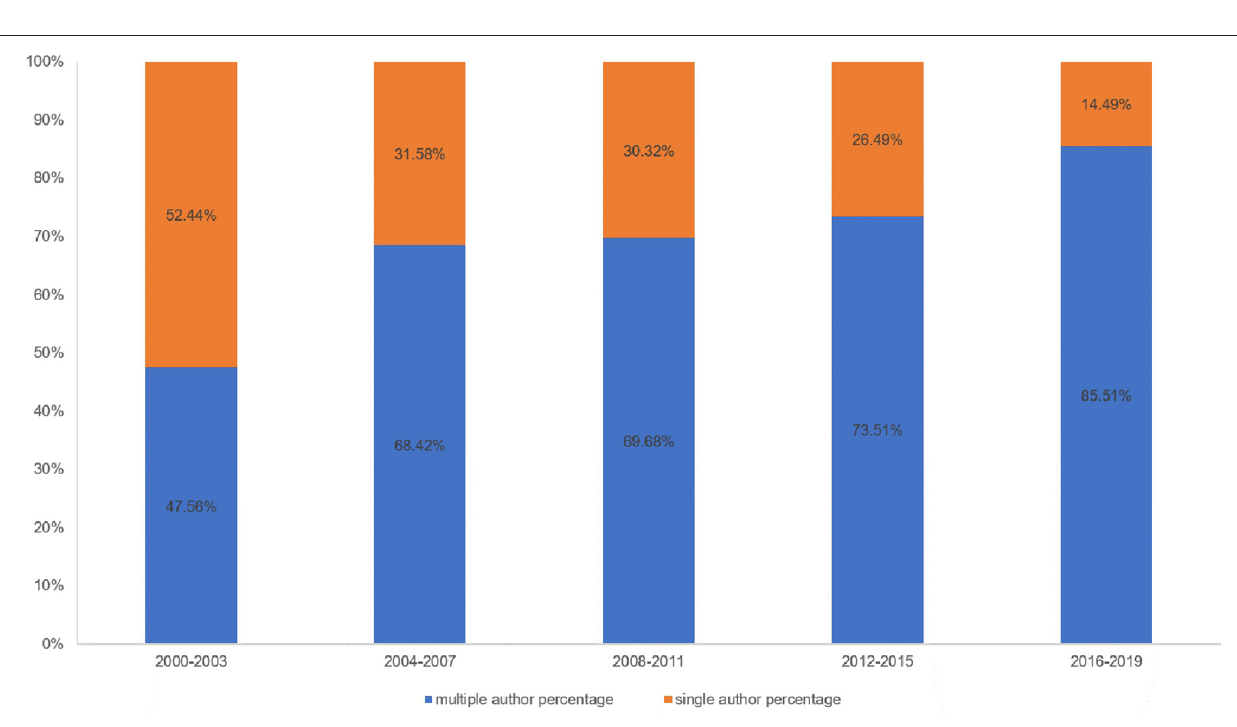
Frontiers in Psychology |